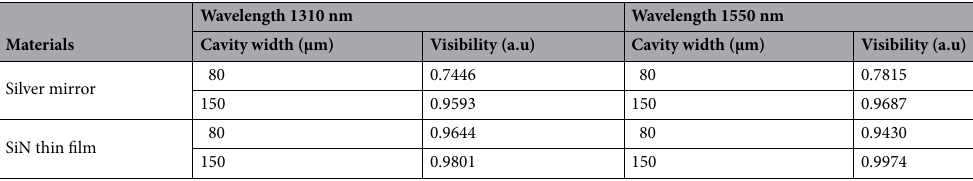
Table 4. Comparison of the visibility values for the tested SiN material and silver for the second and third wavelengths of the telecommunications window.